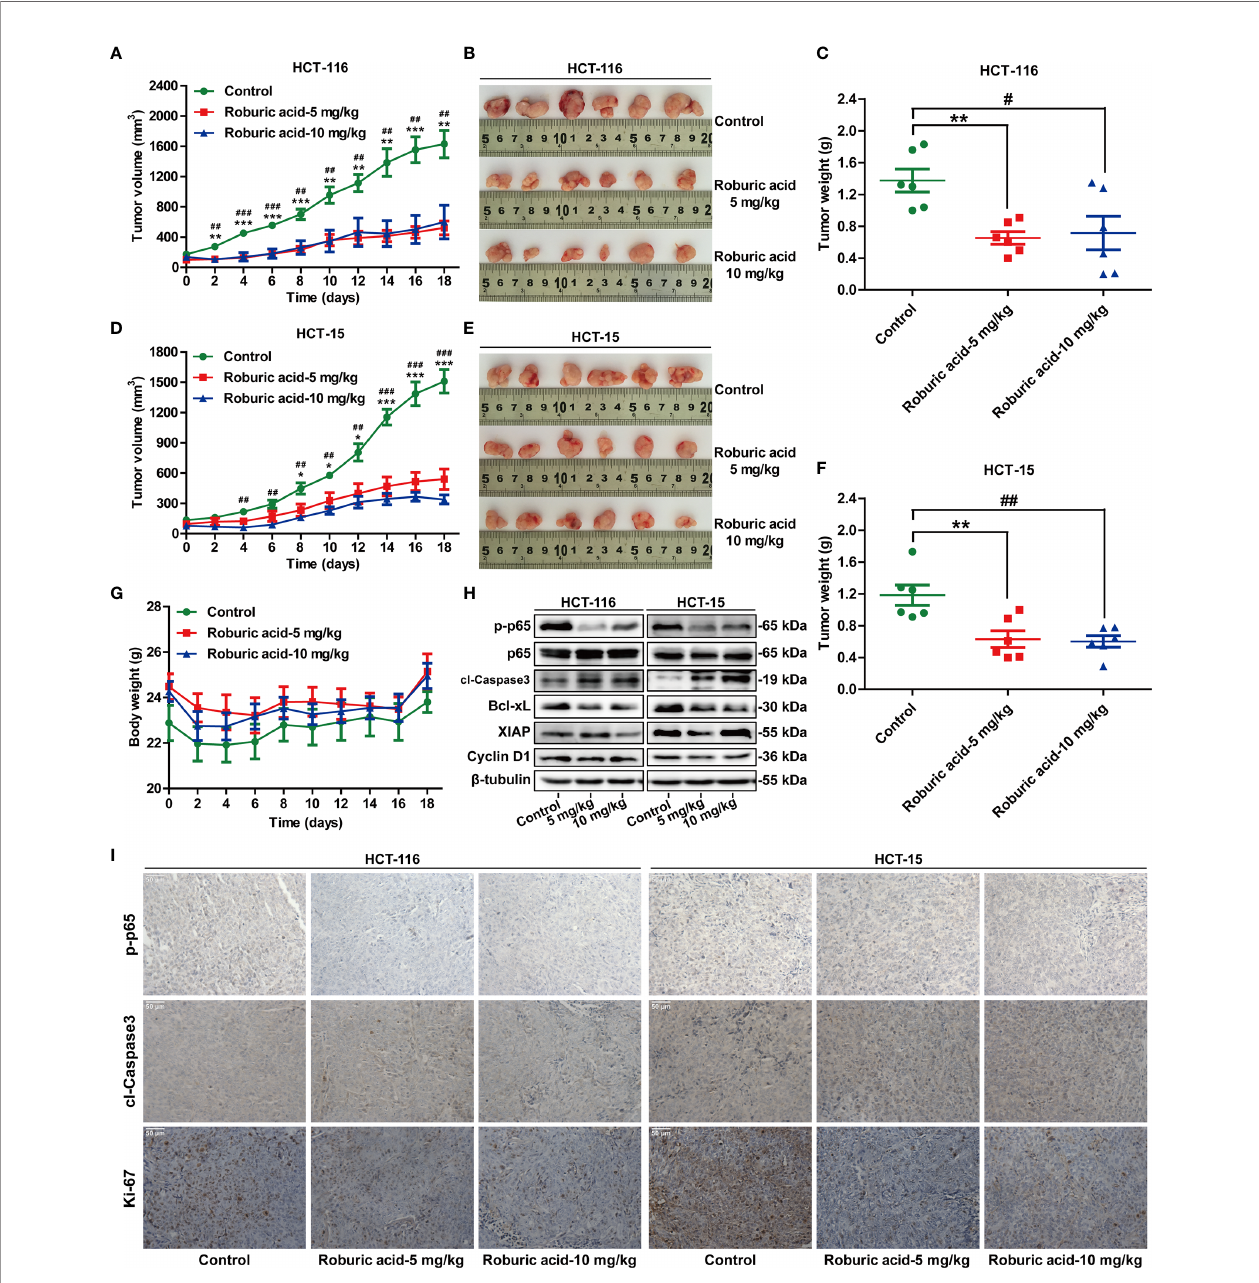
FIGURE 7 | Roburic acid inhibits tumor growth by blocking NF- k B signaling in a xenograft mouse model of colorectal cancer. Roburic acid treatment inhibits tumor growth and weight of HCT-116 (A – C) and HCT-15 (D – F) human colorectal cancer xenografts in nude mice, but does not affect the body weight (G) of either group. (H) Tumor tissues from HCT-116 and HCT-15 xenografts were used for immunoblotting analysis to assess the protein expression of p-p65, p65, cleaved Caspase3 (cl-Caspase3), Bcl-xL, XIAP, and Cyclin D1. Beta-tubulin was used as loading control. (I) Paraf fi n-embedded HCT-116 and HCT-15 tumor tissue sections were immunostained with antibodies against p-p65, cl-Caspase3, and Ki-67 (original magni fi cation ×400). Representative images are displayed. Data are shown as means ± SEM of six mice per group. * P < 0.05, ** P < 0.01, and *** P < 0.001, low-dose roburic acid group vs the control group; # P < 0.05, ## P < 0.01, and ### P < 0.001, high-dose roburic acid group vs the control